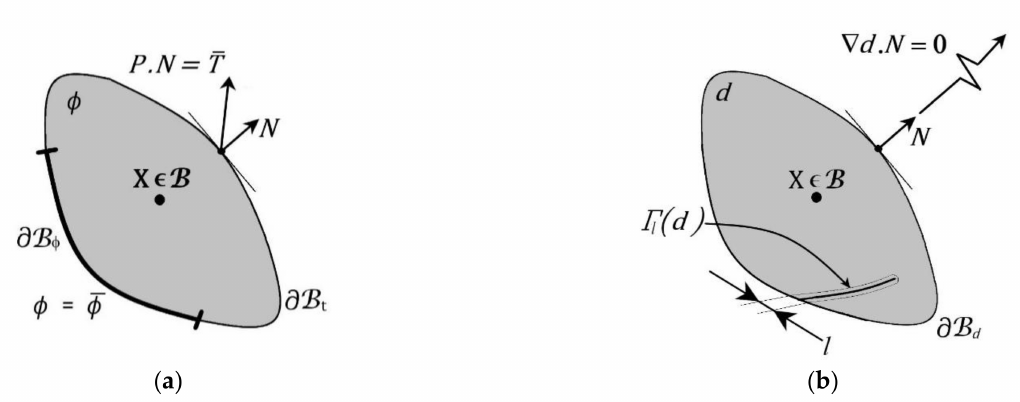
Figure 8. Multi-field problem: ( a ) Deformation with boundary conditions, ( b ) Crack phase-field with boundary conditions [Reprinted with permission from ref. [111], Copyright 2016